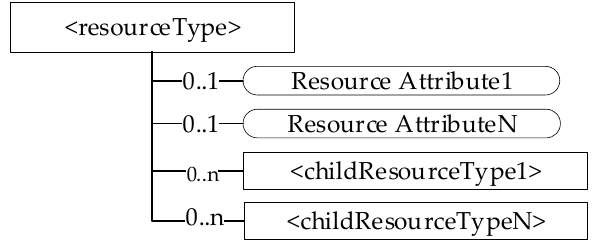
Figure 4. Hierarchical structure of a oneM2M resource.